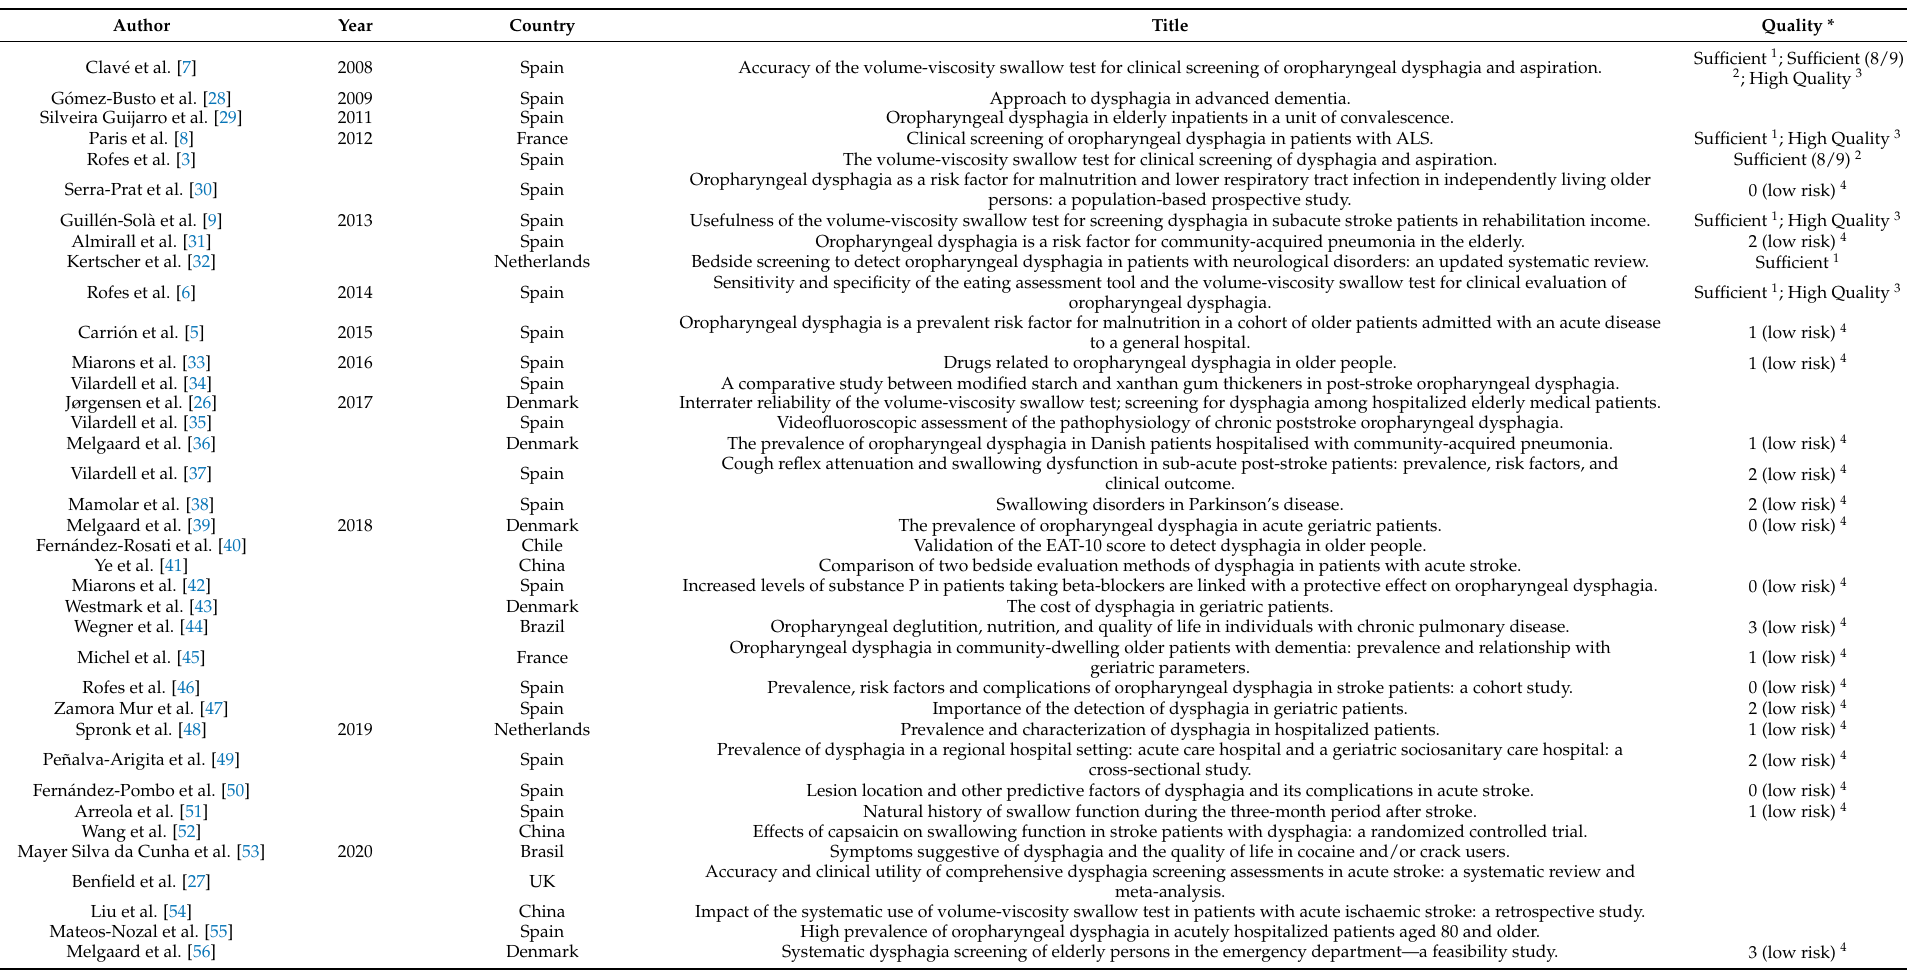
Table 4. Authors, years, countries, and quality of the publications included in the systematic (SR) and scoping (ScR) reviews. Bold depicts studies included in the SR, and no bold indicates studies included in the